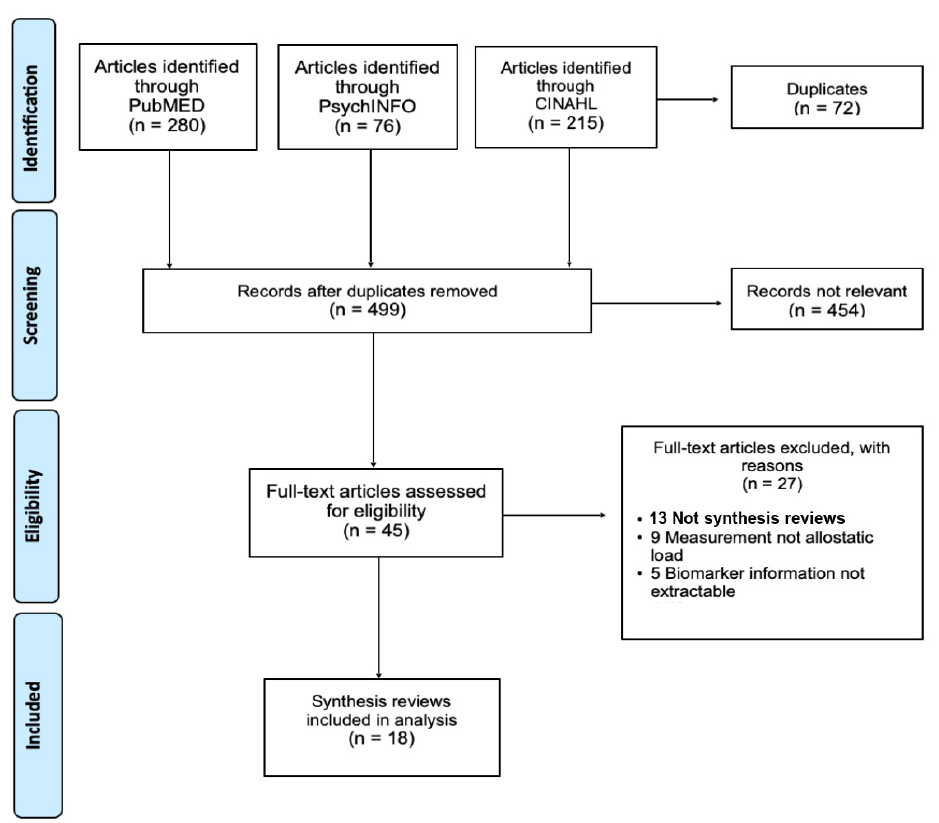
Figure 1. PRISMA Algorithm for the systematic literature search for “allostatic load” conducted on 6 July 2021.